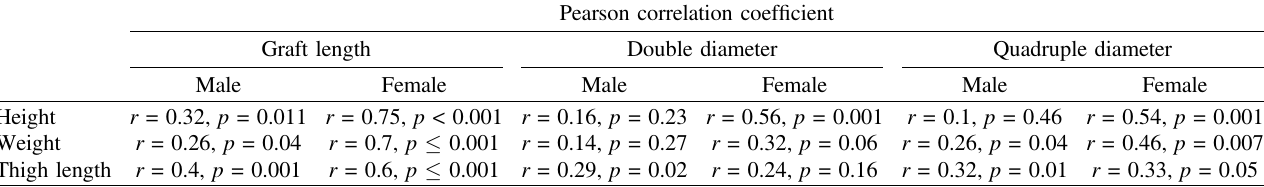
Table 4. Correlation between graft parameters and height, weight and thigh length in males and females.